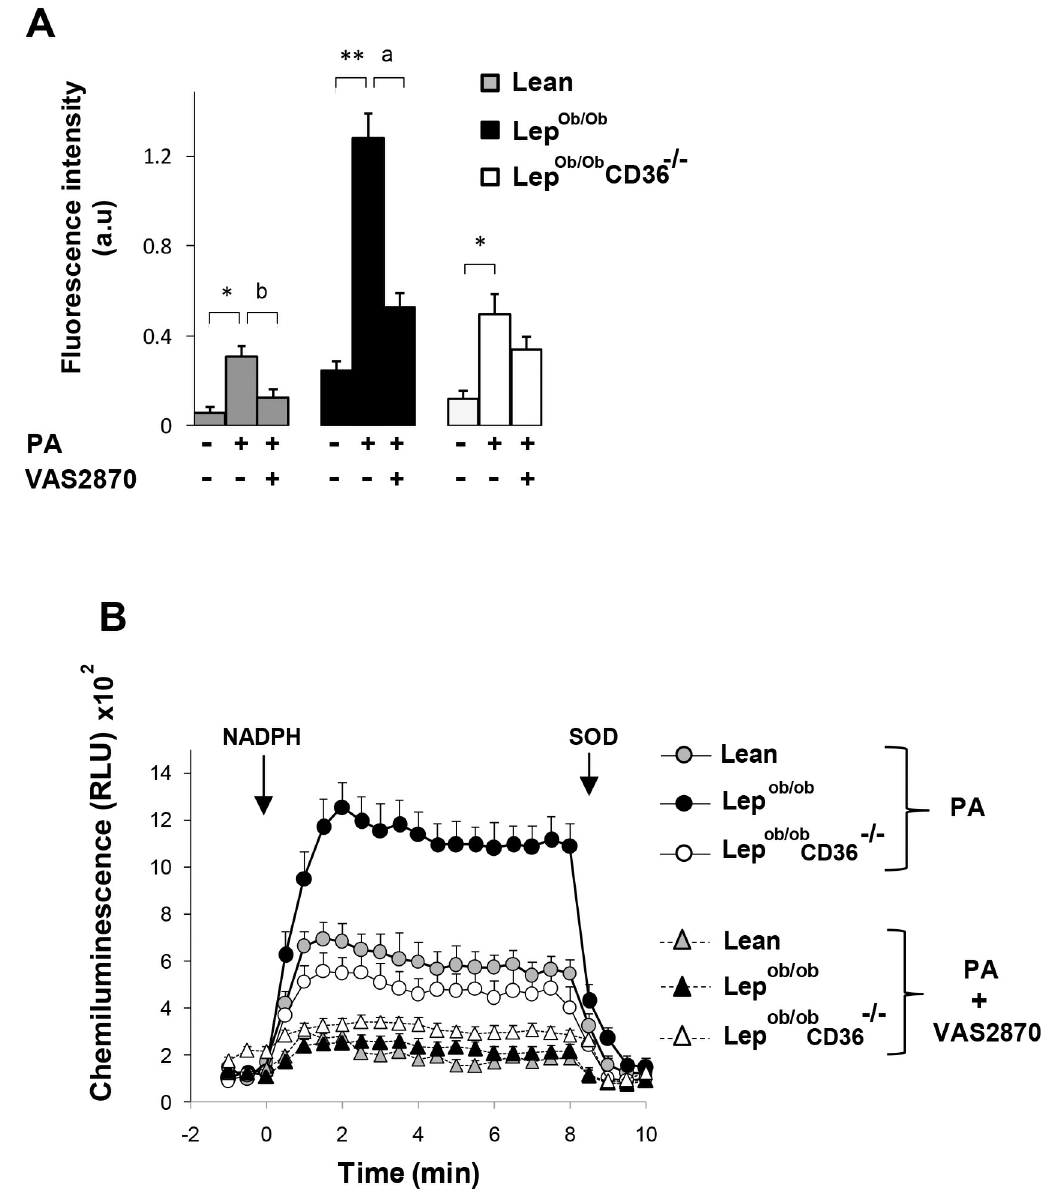
Fig 9. Effects of palmitate treatment on ROS production in cardiomyocytes. Quantification of ROS production with CM-H 2 DCF/DA (A) and lucigenin chemiluminescent method (B) in cardiomyocytes treated with palmitate for 6h in presence or absence of Nox inhibitor VAS2870. For measurement of superoxide production, cells were loaded with loaded with 0.5 μ M CM-H 2 DCF/DA in PBS and fluorescence was recorded using a microplate reader with 530nm emission and 485nm excitation. Background fluorescence was measured in control cells without dye loading and subtracted from all data. Measurements of superoxide production with lucigenin chemiluminescent method are performed as described in the Method section. Data are means ± SEM of triplicates from an n = 4 mice per group. Differences between untreated and palmitate-treated cells of the same genotype are indicated with asterisks ** p < 0.01 and * p < 0.05. Differences between palmitate-treated and palmitate-VAS2870-treated cells of the same genotype are indicated with alphabetic letters a p < 0.01 and b p <